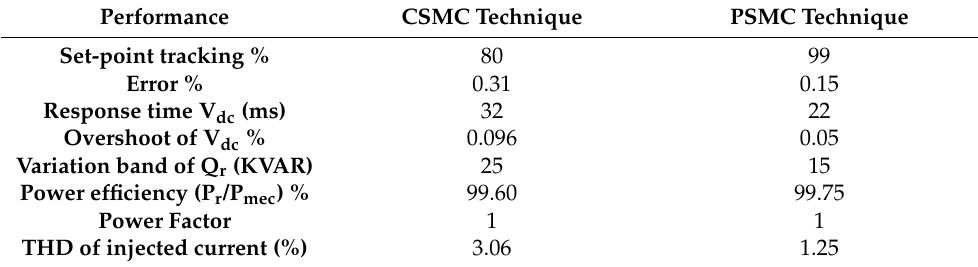
Figure 11. ( a ) THD using CSMC and ( b ) THD using PSMC. Table 1. Performance Comparison Between the conventional SMC and the proposed approach for the WECS overtime period.